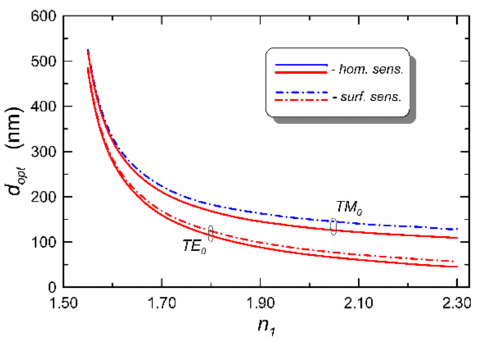
Figure 8. Optimum thickness of the waveguide films corresponding to the maximum values of the homogeneous and surface sensitivity,